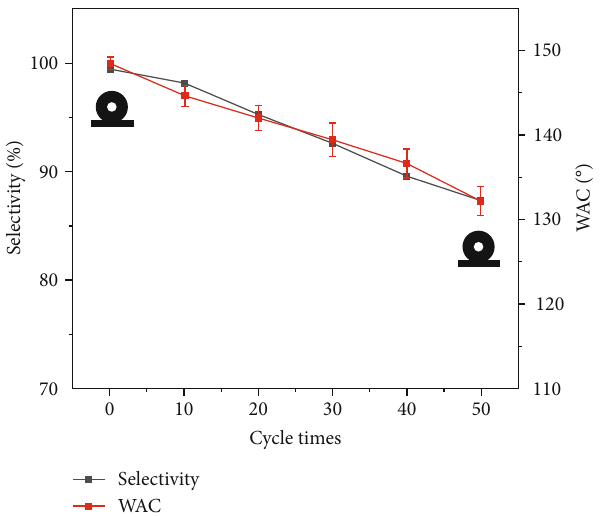
Figure 10: Change of selectivity and water contact angle of modi fi ed sponge with the number of